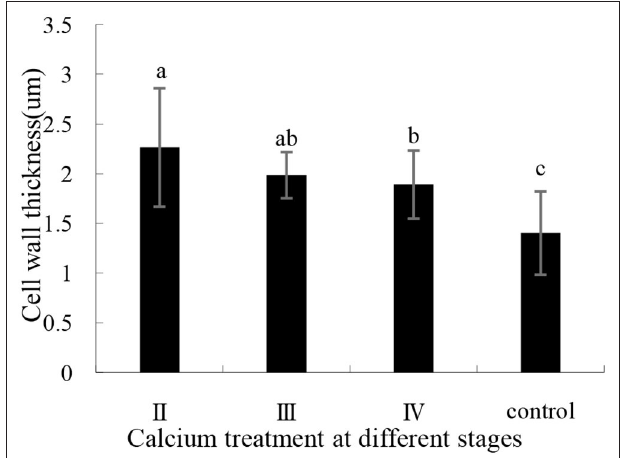
FIGURE 7 | Pericarp cell wall thickness with calcium treatment in different stages. Data are presented as mean ± standard. Lowercase letters represent significant differences ( P < 0.05).